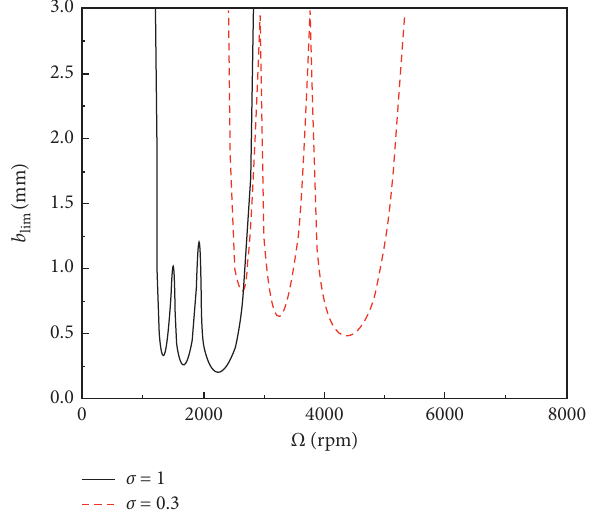
Figure 11: The stability lobe diagrams of the tapered composite cutter bar and tapered composite cutter bar and uniform composite cutter